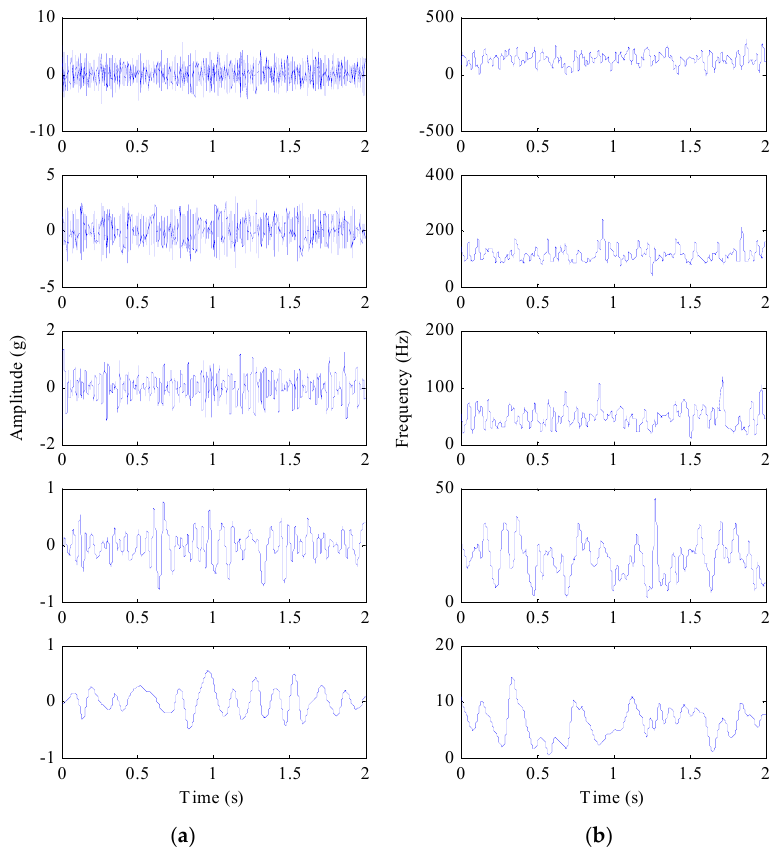
Figure 2. The decomposition of x ( t ) with SNR of − 5 dB by LMD: ( a ) PFs in the time domain; ( b ) PFs in the frequency domain.